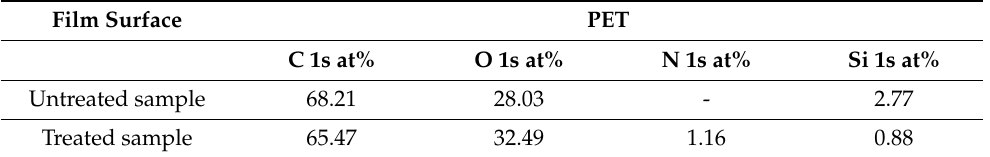
Table 1. Changes of element content pre- and post-plasma